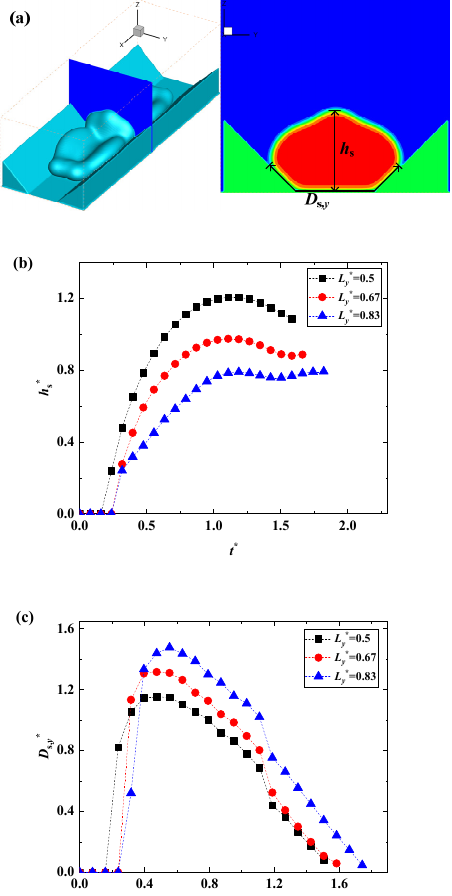
Figure 11. ( a ) The depiction of h s and D s, y of the sheet. The evolutions of ( b ) h s * and ( c ) D s, y * for various L y * at L x * =